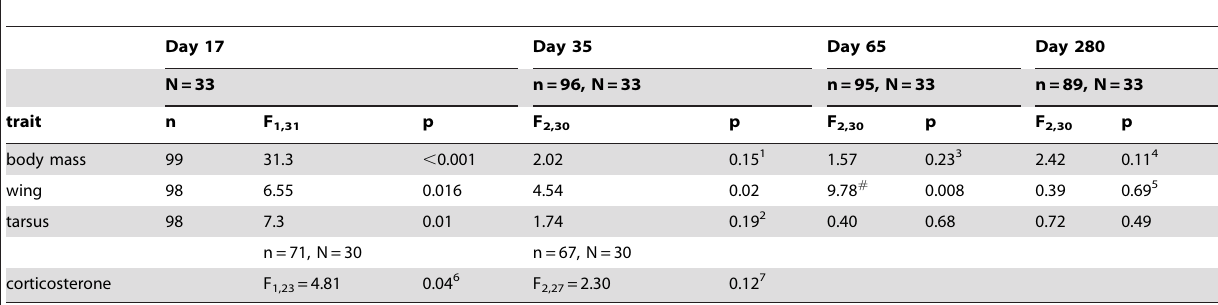
Effects tested with linear mixed effect models (LME) with upper case numbers indicating significant factors/interactions within the final model (N = nests, which subjects came from, n =